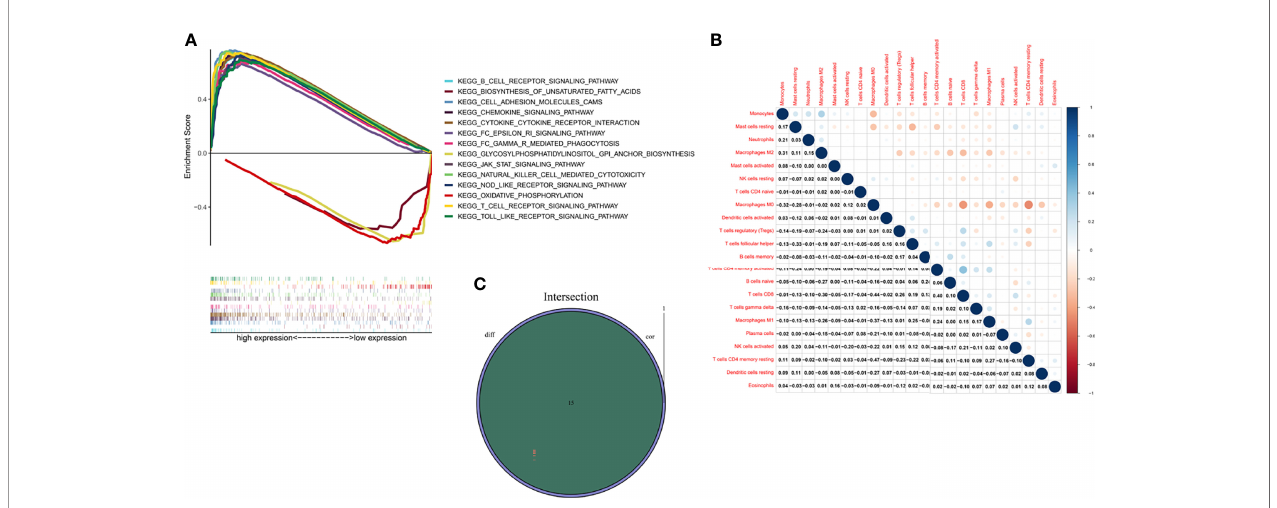
FIGURE 7 | GSEA, TICs correlation and Venn diagram for ITK expression related TICs. (A) GSEA of BC samples in high and low expression groups. Nominal p < 0.01 were considered signi fi cant. (B) Heatmap was used for visualizing the correlation between 22 kinds of TICs. The deeper the color, the more signi fi cant the correlation is. Pearson coef fi cient was used for the signi fi cance test. (C) Venn diagram highlighted the ITK expression related immune cells, which were determined through difference and correlation